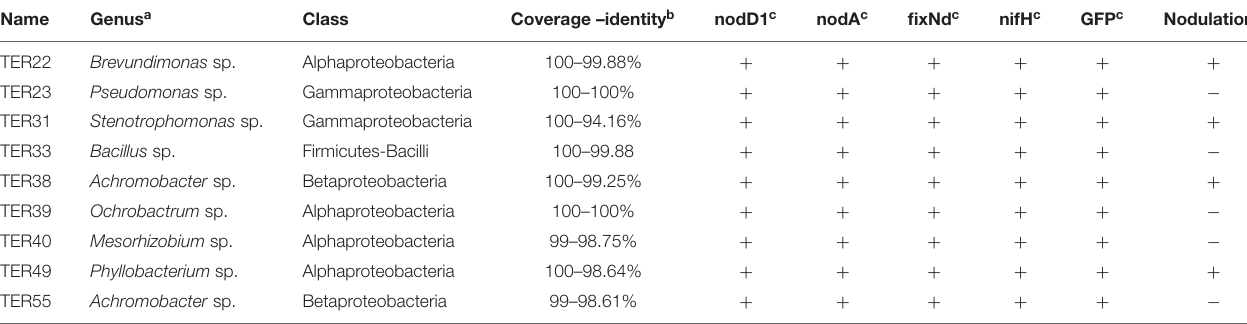
TABLE 2 | Characteristics of putative transconjugants from endophytic recipients isolated from